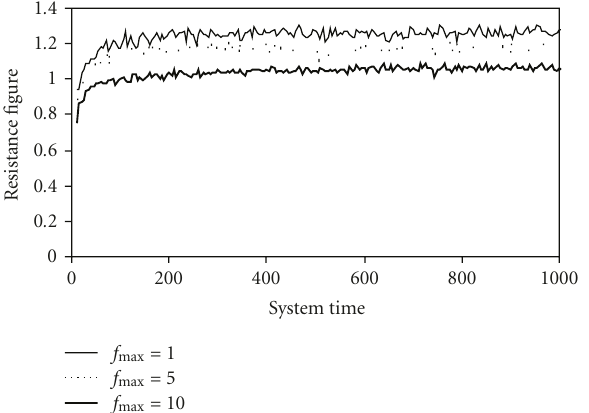
Figure 9: Resistance figure under di ff erent values of f max .